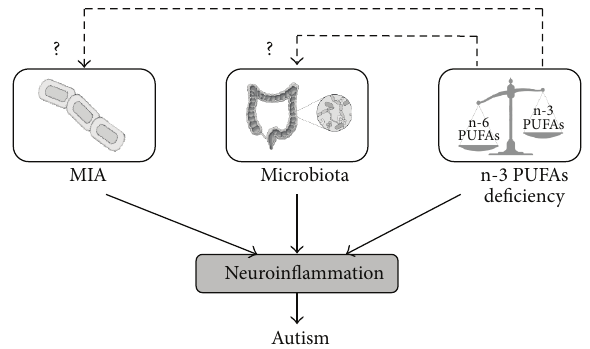
Figure 3: Environmental factors influencing neuroinflammation in autism. Early inflammation in the brain is a well-recognized risk factor for autism. Neuroinflammation is a process influenced by environmental factors such as MIA, microbiota, and n-3 PUFAs deficiency. However, crosstalks between these factors can make the situation increasingly complex. For instance, insufficient dietary n-3 PUFAs intake unavoidably impacts microbiota composition as well as MIA immunoreactivity possibly potentiating the proinflamma- tory response. This, in turn, can lead to increased risks for